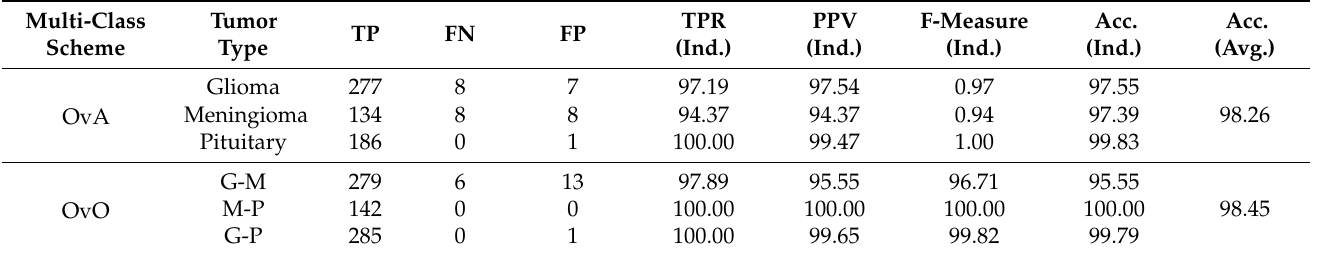
Table 8. Comparison of coding schemes: (OvA and OvO) for performance analysis without aug- mentation (G, M, and P represent glioma, meningioma, and pituitary tumors, respectively, using 224 × 224 image